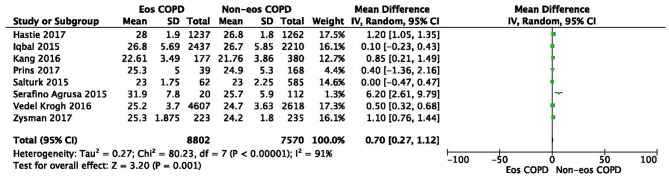
Comparison of BMI character between eosinophilic and non-eosinophilic COPD. SD, standard derivation; IV, Inverse Variance; CI, confidence interval; BMI, body-mass index; Eos, eosinophilic; Non-eos, non-eosinophilic; COPD, chronic obstructive pulmonary disease.